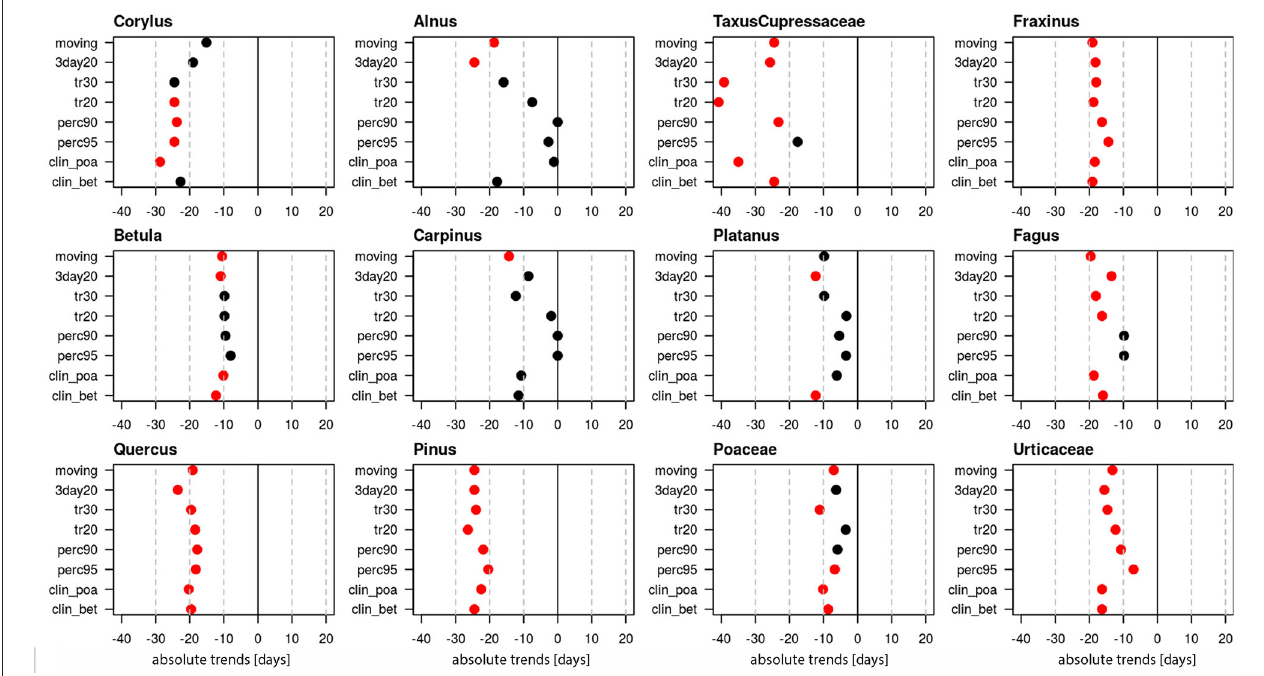
FIGURE 1 | Absolute trends [days] for the 50-year period 1969–2018 of the start dates of the pollen season with eight different pollen season definitions. Red points show significant trends ( p -value ≤ 0.05), black points show non-significant trends.